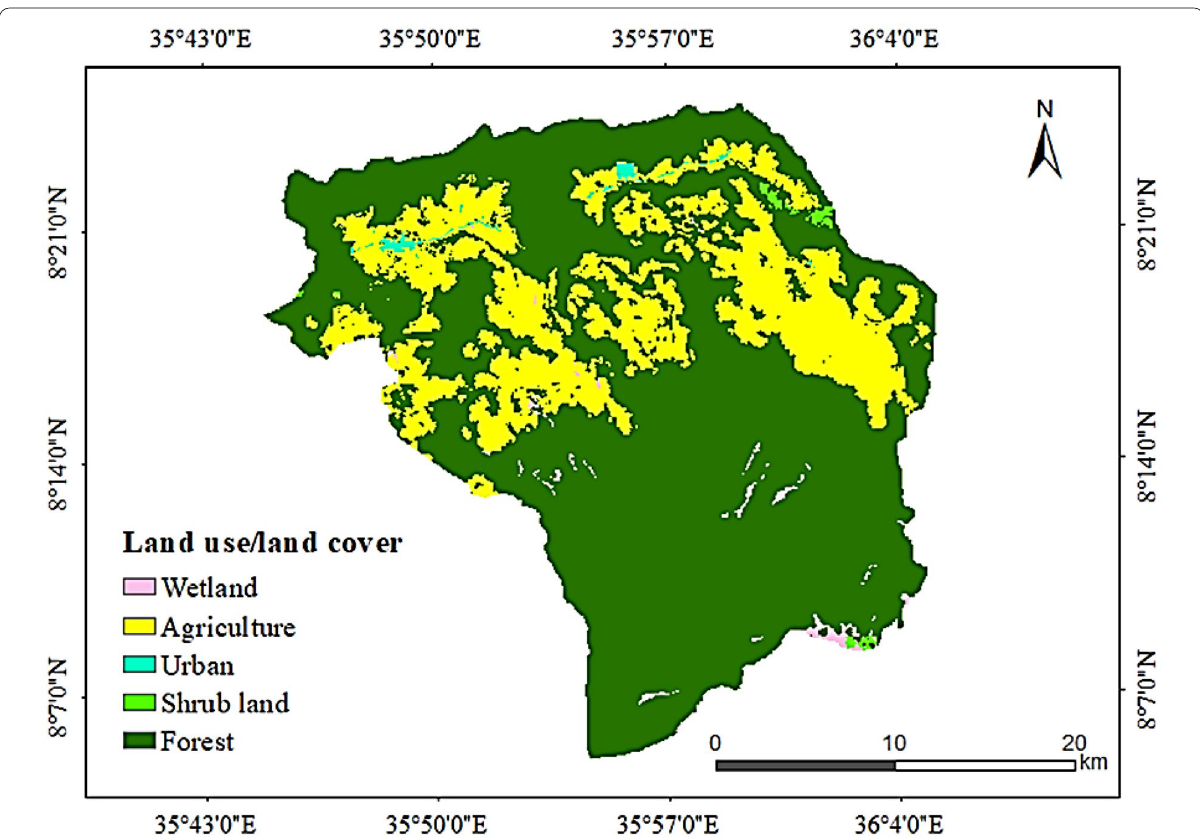
Fig. 3 Land use land cover map of the Yayu forest in the study area, showing the forests distributed in the high altitude parts of the mountain and in the valley